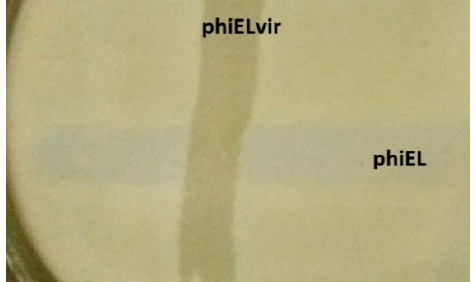
Figure 6. Growth of a virulent mutant phiElvir (no opalescence) over a wild variant of phage phiEL (opalescence). In the place of joint infection, opalescence has disappeared.